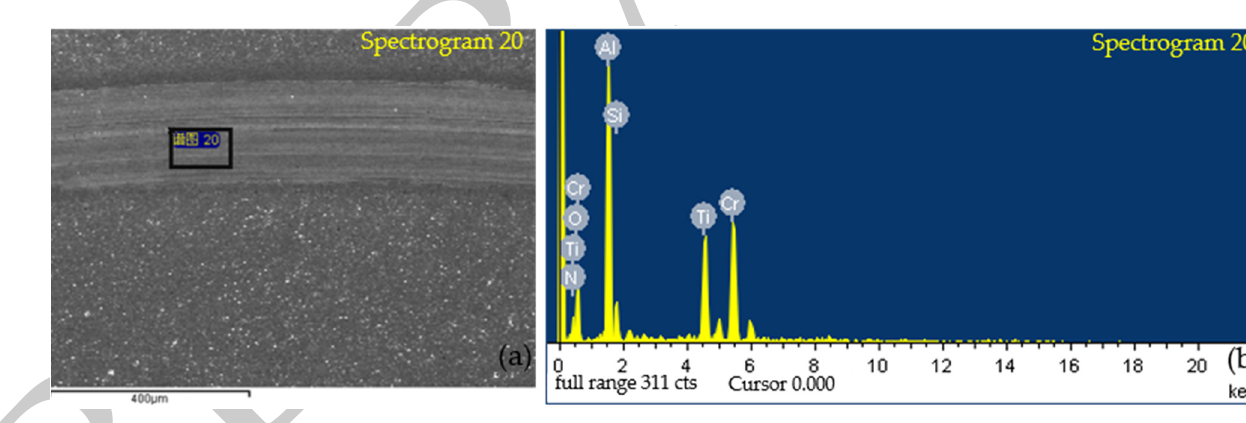
Figure 12. SEM morphology and EDS analysis of the worn scar for the AlCrTiSiN coating after annealing at 800 °C. ( a ) SEM morphology, ( b ) EDS test chart.